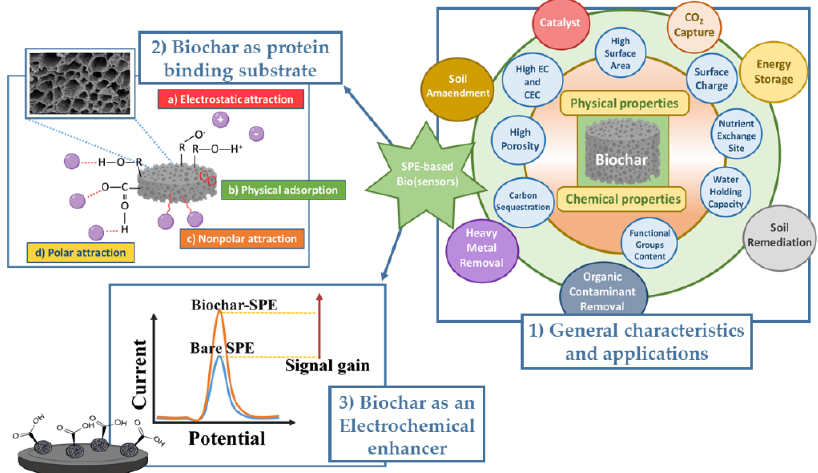
Figure 1. Chemical–physical properties of biochar and its application in the development of electro- chemical SPEs ‐ based biosensors.